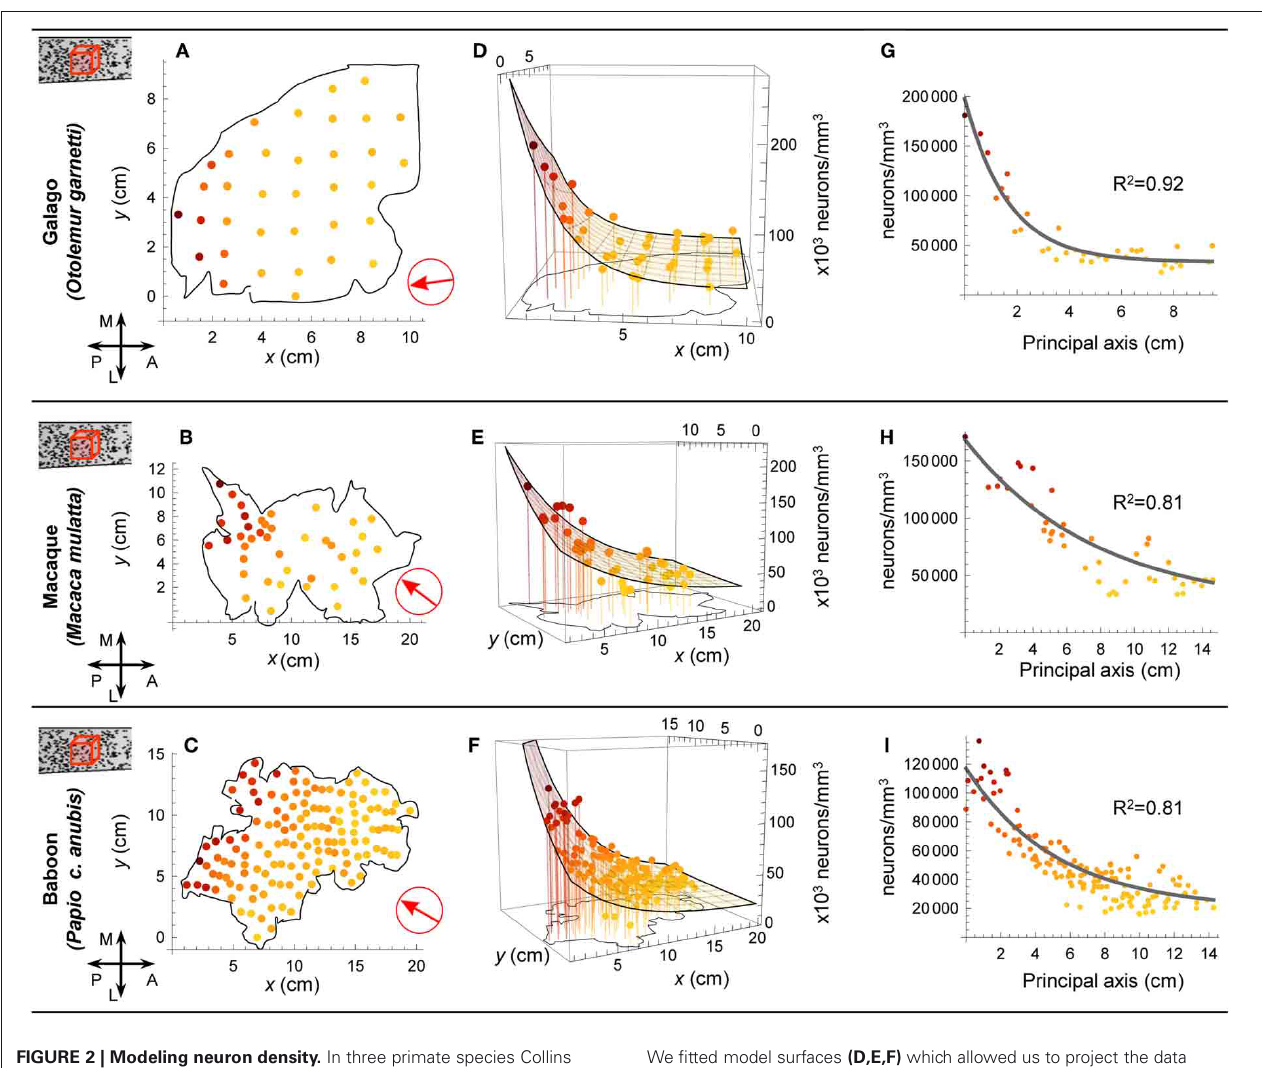
FIGURE 2 | Modeling neuron density. In three primate species Collins et al. dissected the cortex into multiple samples and recorded the density of neurons in each dissected piece. In (A , B, and C) we denote the locations of the samples on the flattened cortical sheet.